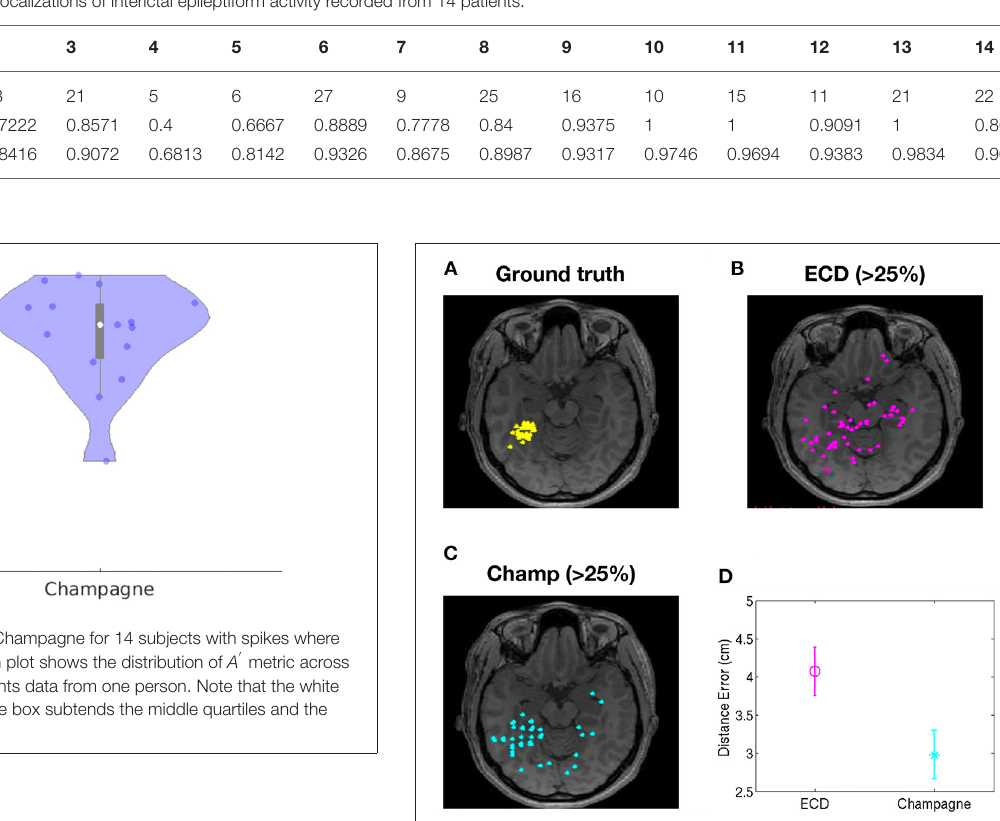
FIGURE 3 | Localization of high-error spikes by ECDss and Champagne algorithms: Subject 1. (A) Ground truth as defined by localizations of spikes by ECDss with errors < 10%. (B) Localizations of spikes by ECDss with error > 25% (C) Localization results when spikes with error > 25% by ECDss were then localized using the Champagne algorithm. (D) Distance between the ground truth (A) and the localization result by ECDss (B) and Champagne (C) for those spikes with ECDss error > 25%. For (D) , whiskers indicate SEM.